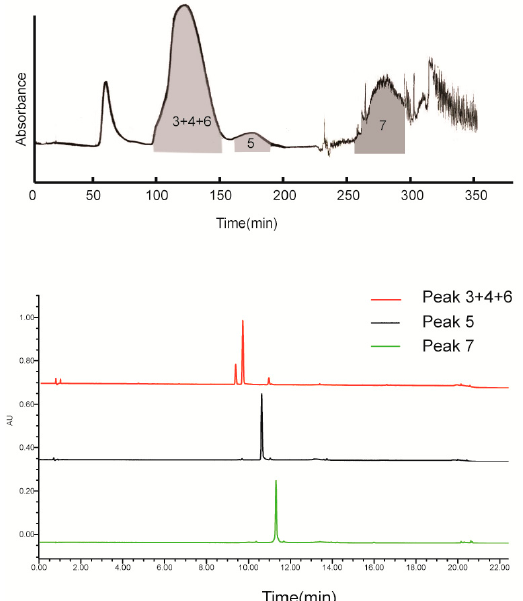
Figure 5. 1D HSCCC chromatogram of Fr.2 and HPLC chromatogram of the three HSCCC fractions (Peak 3 + 4 + 6: the mixture of neoastilbin, astilbin, and isoastilbin; Peak 5: neoisoastilbin; Peak 7: engeletin). HSCCC condition was the same as that of Figure 4.